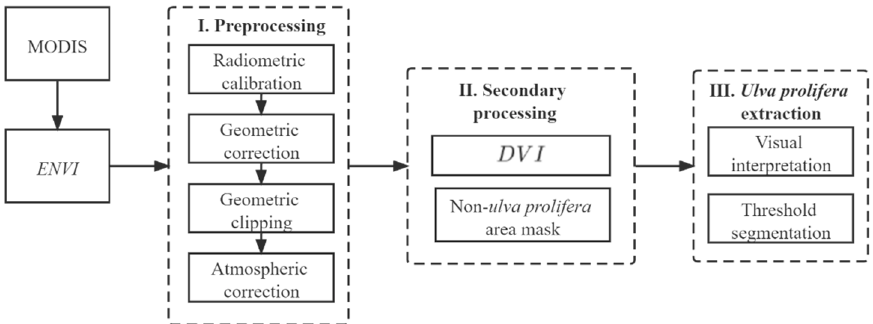
Figure 2. Flow chart of MODIS image preprocessing.